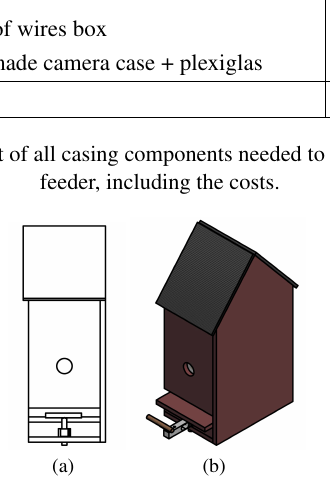
Figure 2. (a) Frontal view, (b) 3D-model © Sebastian